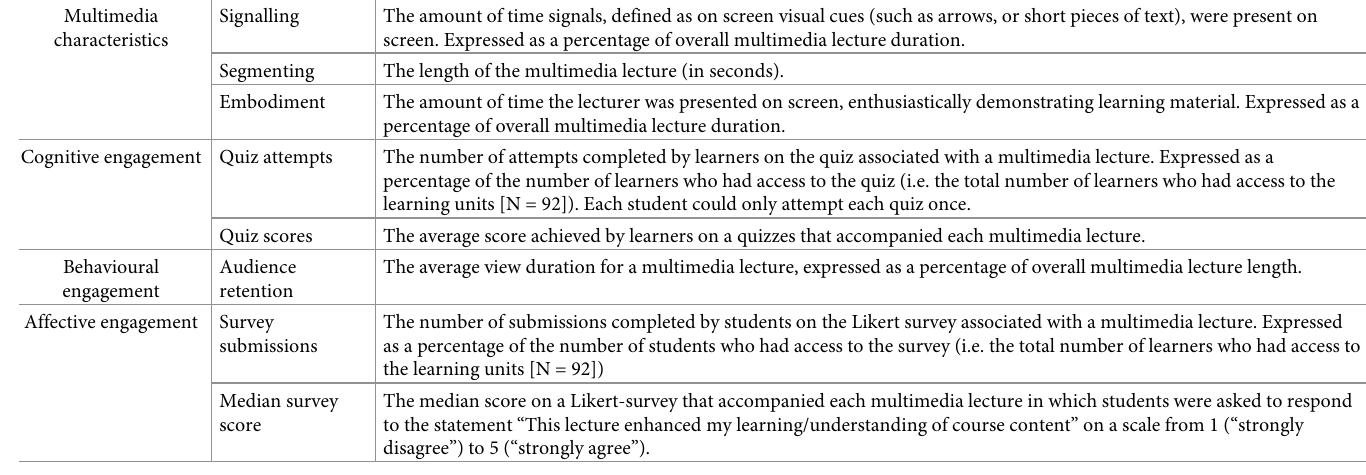
Table 1. The complete list of and definitions of the experimental outcomes, including the multimedia characteristics and measures of engagement. Multimedia